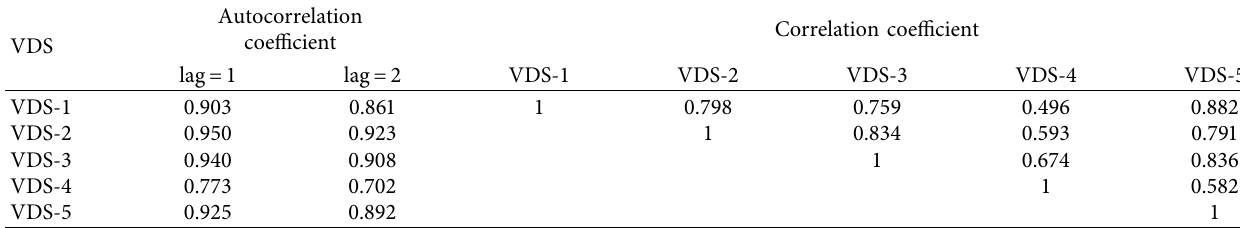
Table 3: Autocorrelation coefficient and correlation coefficient of VDS-1 to VDS-5.